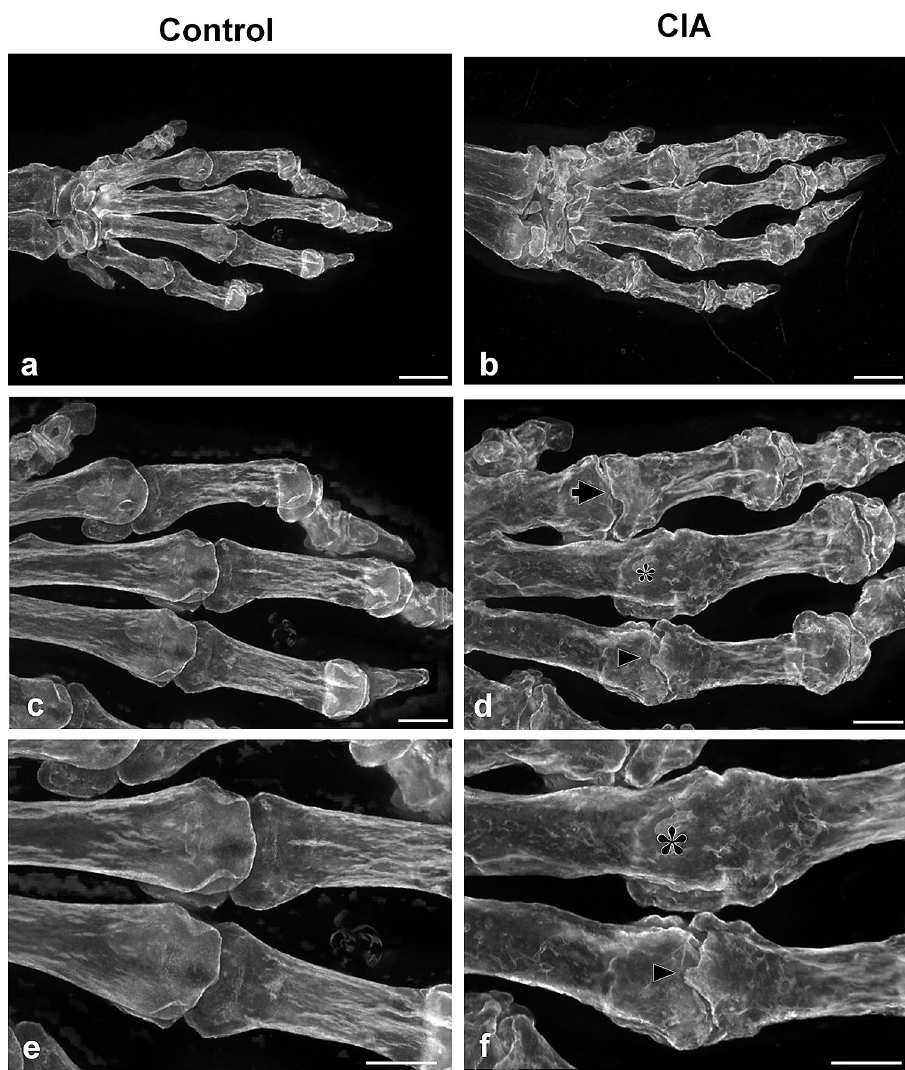
Figure 5. Extended-focus fluorescent images of the phalanges and their joints in the control ( a , c , and e ) and CIA mice ( b , d , and f ). Bone erosion was frequently observed in the phalanges of CIA mice. In the metacarpophalangeal joints of CIA mice, the articular surface in both the head of the metacarpals and the base of the proximal phalanx was uneven, but not smooth. In addition, the cavum articulare was narrow (arrows in d ). Occasionally, the head of the metacarpals and the base of the proximal phalanx were fused (synarthrosis), and the cavum articulare disappeared (asterisks in d and f ). Phalanges osteophytes were observed from the articular surface (arrowhead in f ). Scale bar in a – b : 1 mm; in c – f : 500